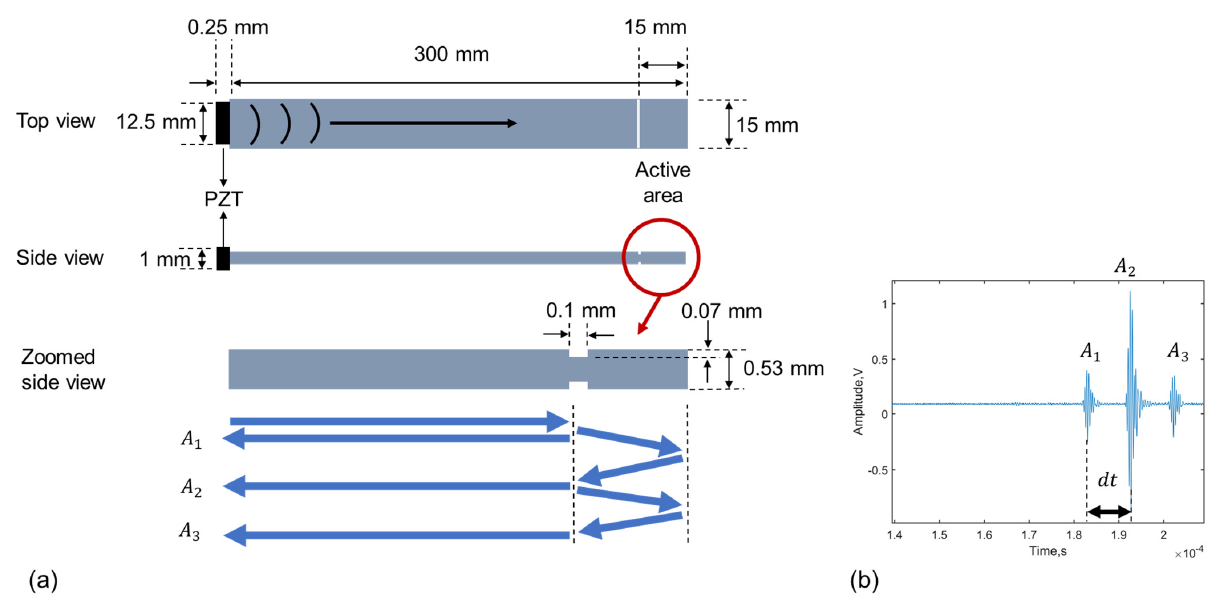
Figure 1. ( a ) Schematic diagram of the waveguide used in this study demonstrating the propagation of ultrasonic wave including the first, second and third echoes; and ( b ) an example of a received signal, indicating the arrival time difference between the echoes.